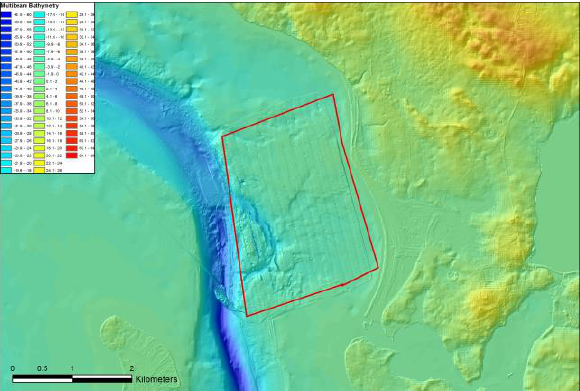
Figure 2 Combined satellite and multibeam surveys over the land coast and sea of the Danish case study site showing a truly seamless approach to mapping of coastal sites.